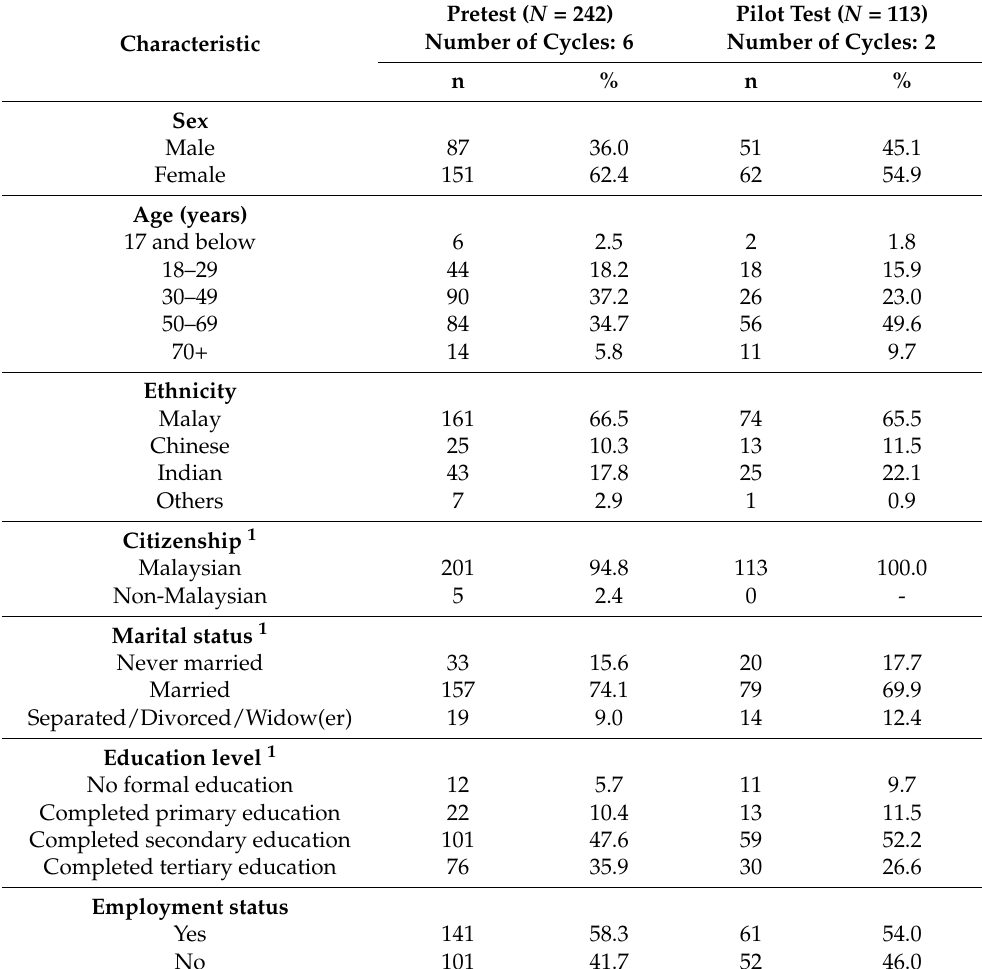
Table 2. Characteristics of respondents during qualitative testing.